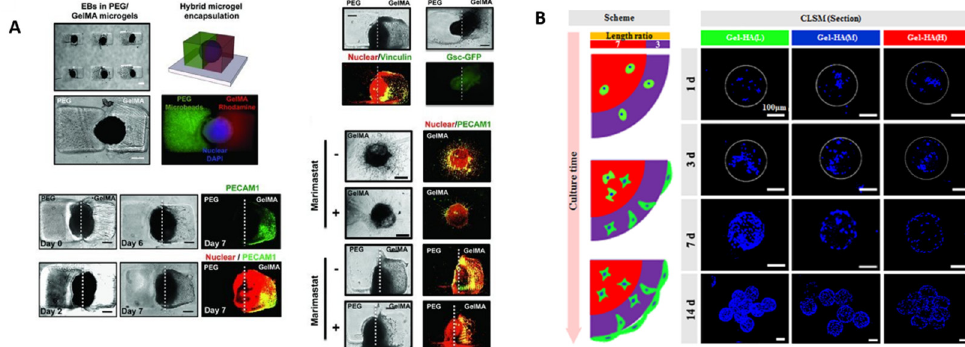
Figure 3. ( A ) Polarity induction in individual embryoid bodies (EBs) encapsulated in GelMA/PEG hybrid microgels with spatially patterned vasculogenic differentiation. All scale bars: 300 μ m. Reproduced with permission from Ref. [57]. Copyright 2010 Wiley-VCH. ( B ) Bone marrow mesenchymal stem cell (BMSC) distribution in three gelatin/hyaluronic acid hybrid microgels with low, me- dium and high crosslinking densities. Reprinted from Ref. [58], Copyright 2020, with permission from Elsevier. Table 3. Significative examples of CLMs investigating embryonic development or polarization of cells.